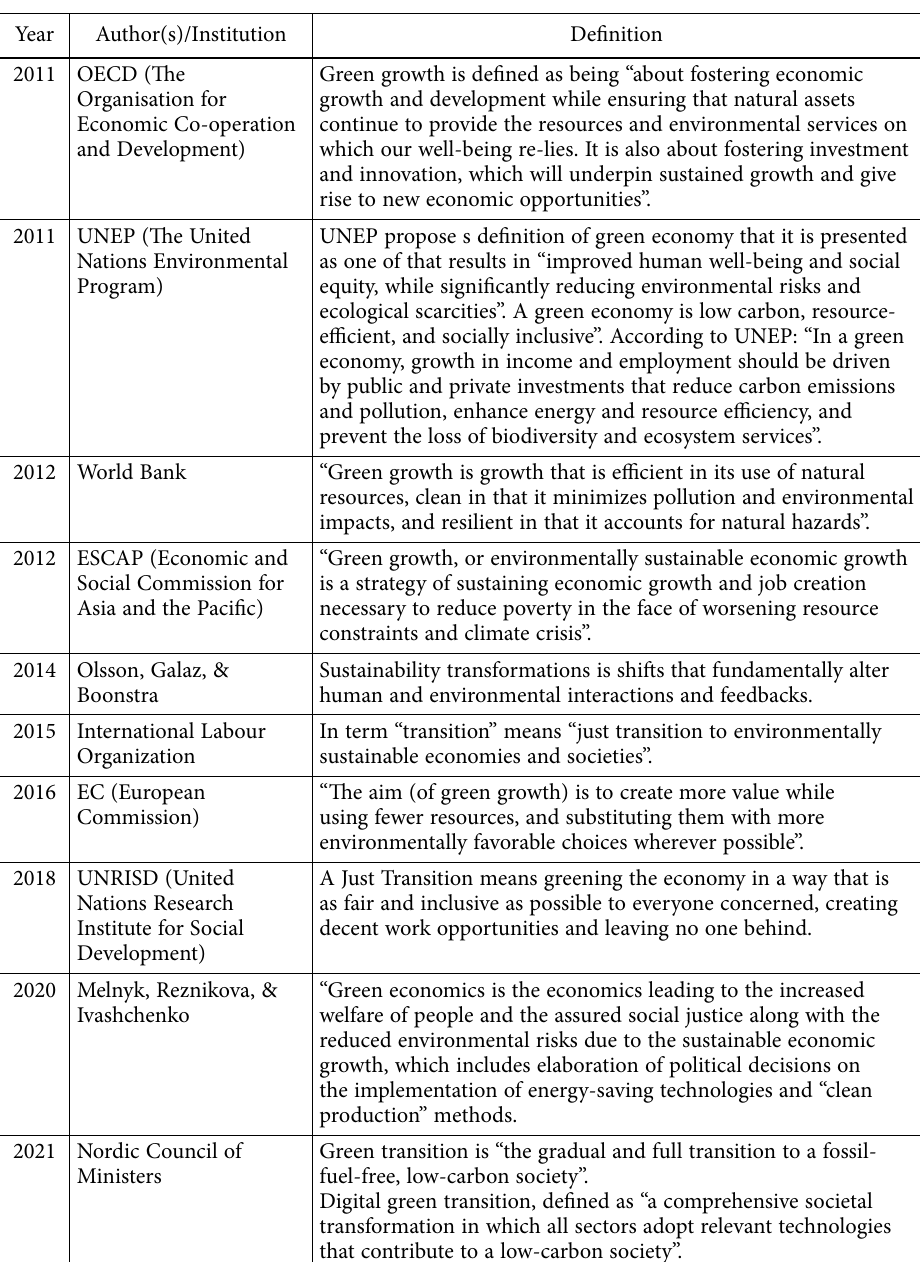
Table 1. Green transition and green transformation – a various proposal of